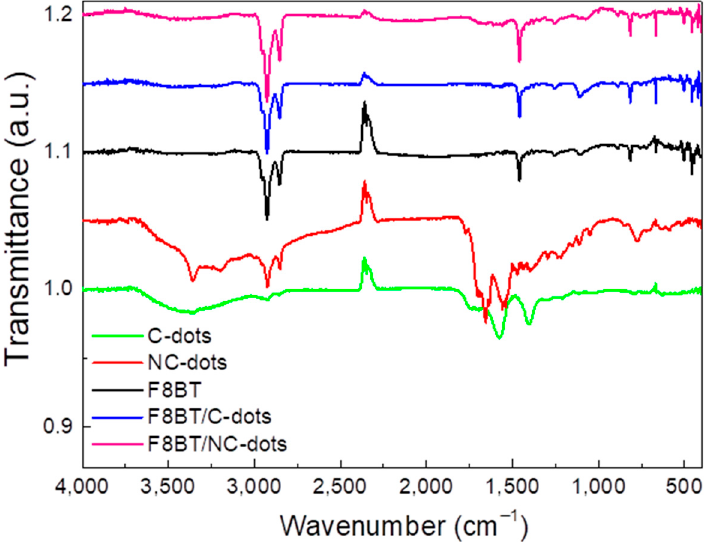
Figure 3. FTIR spectra of pristine carbon dots and F8BT films and of F8BT/C-dot and F8BT/NC-dot interfaces.